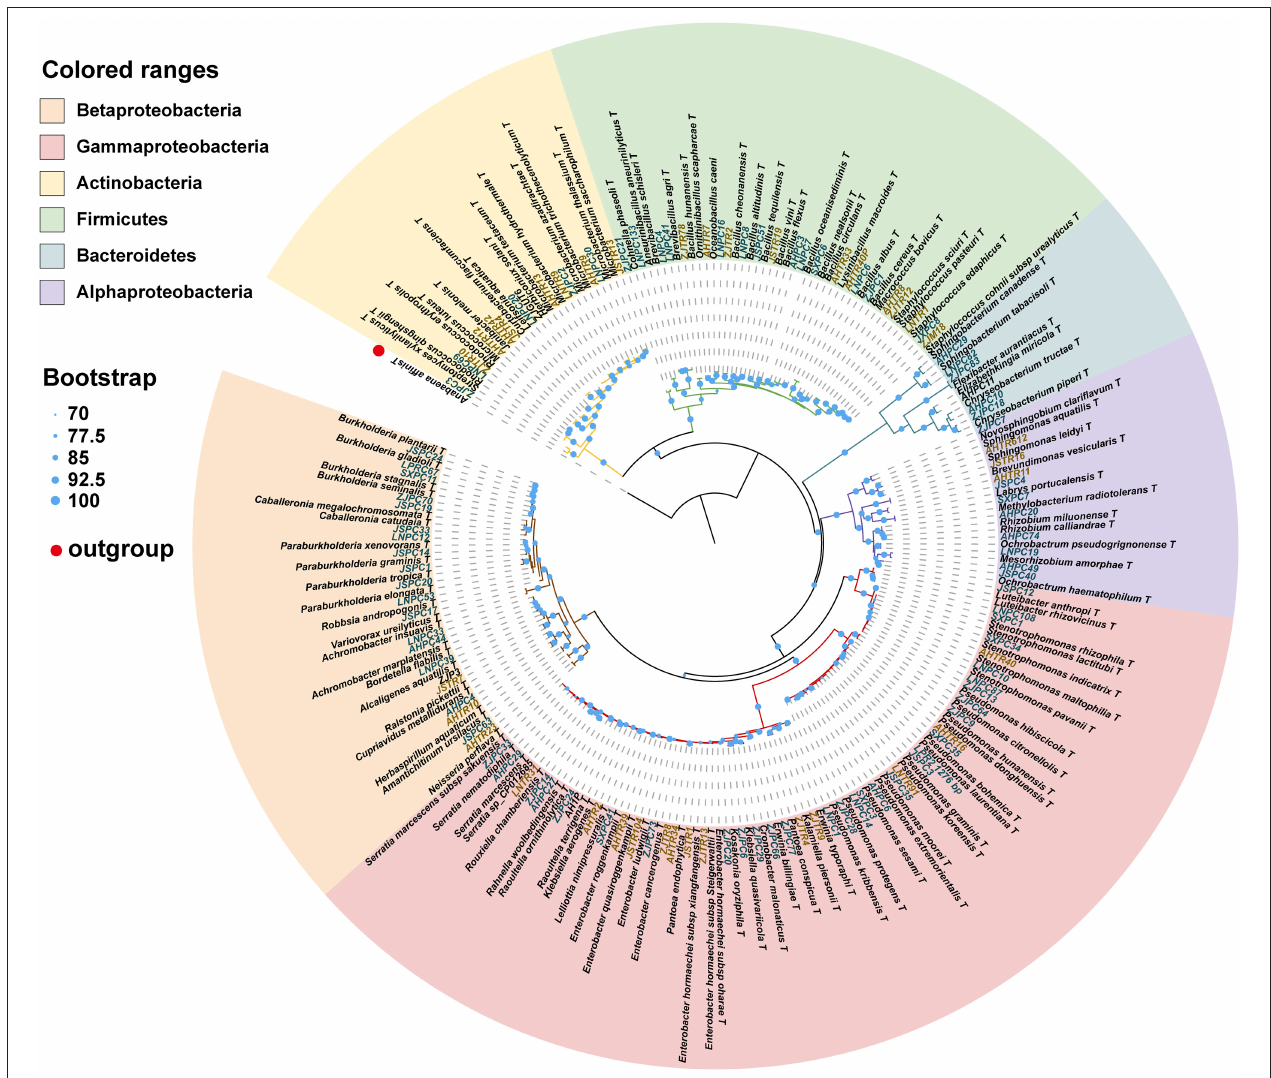
FIGURE 3 | Phylogenetic tree showing the placement of 118 bacterial isolates with reference strains based on 16S rDNA sequence. The phylogenetic tree was produced by ML methods with 1,000 bootstrap replicates. Bootstrap values are represented by circles at each node. The letters in green: strains isolated from pupal chambers; letters in orange: strains isolated from tracheae. The type of strain indicated with “T”. LNPC67: bacteria strain isolated from pupal chambers in Liaoning province. AHTR10: bacteria strain isolated from tracheae in Anhui province (also see Supplementary Table 1